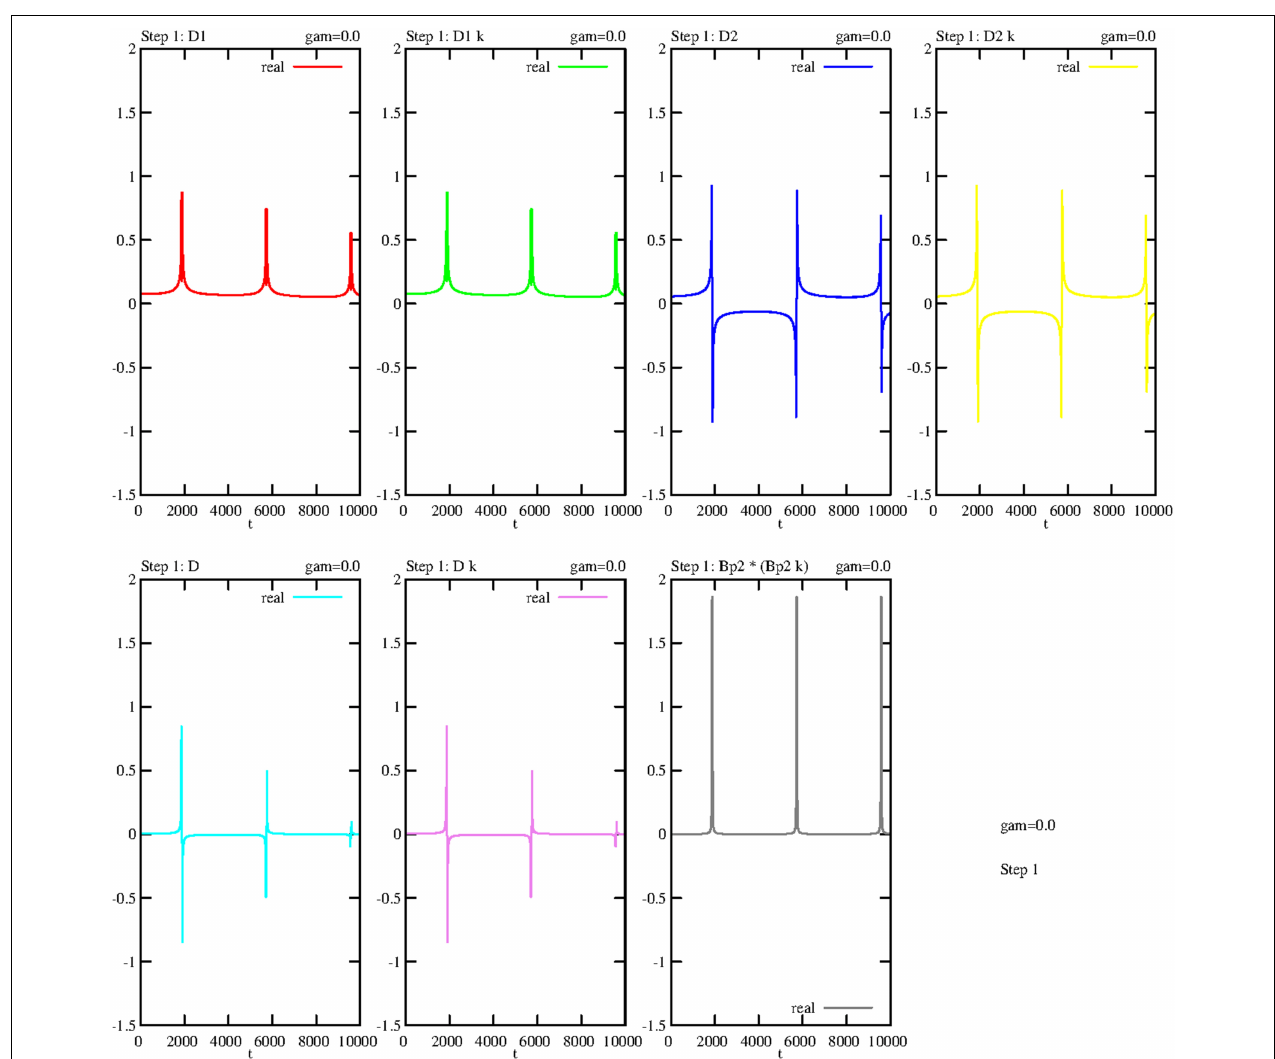
FIGURE 11 | Undamped temporal curves, showing the real parts of the operator products D 1 , D † 1 (abridged to D 1 k ), D 2 , D † 2 (abridged to D 2 k ), D , D † (abridged to D k) and B † p B p 2 , consecutively outlined for step 1. The damping constant is γ 2